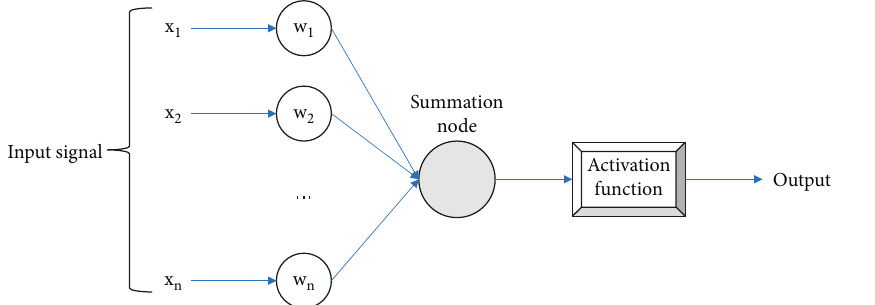
Figure 2: Artificial neuron structure.